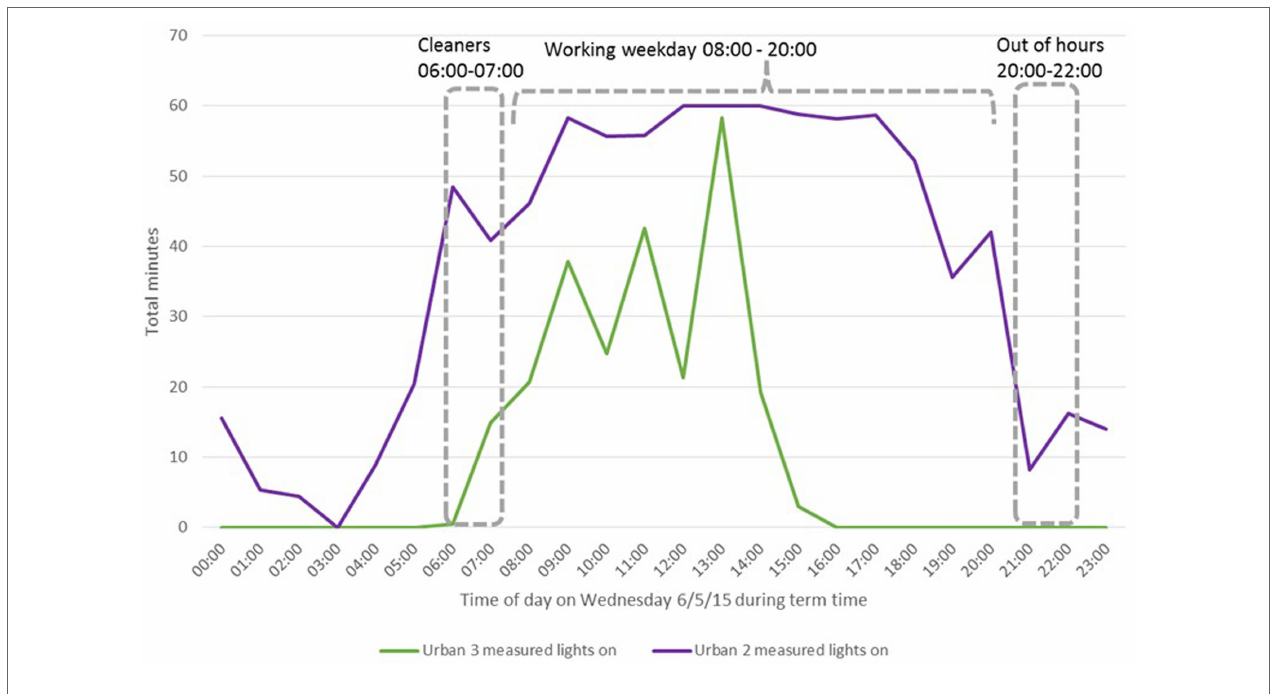
FigUre 10 | Typical term time weekday lights on for Urban 2 and Urban 3 corridor